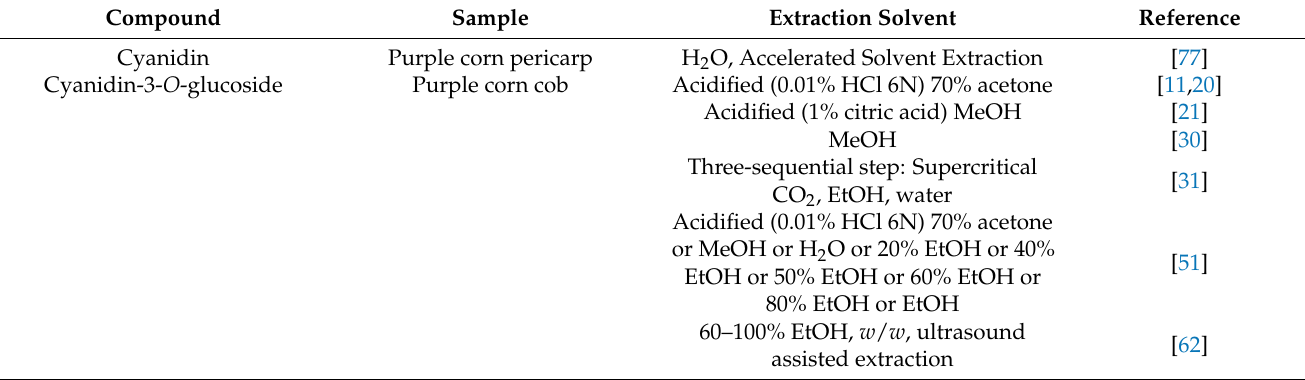
Table 1. Secondary metabolites of colored corn (kernel, cob, and flour and derived products). If not specified, the extraction method consisted in a solid/liquid extraction